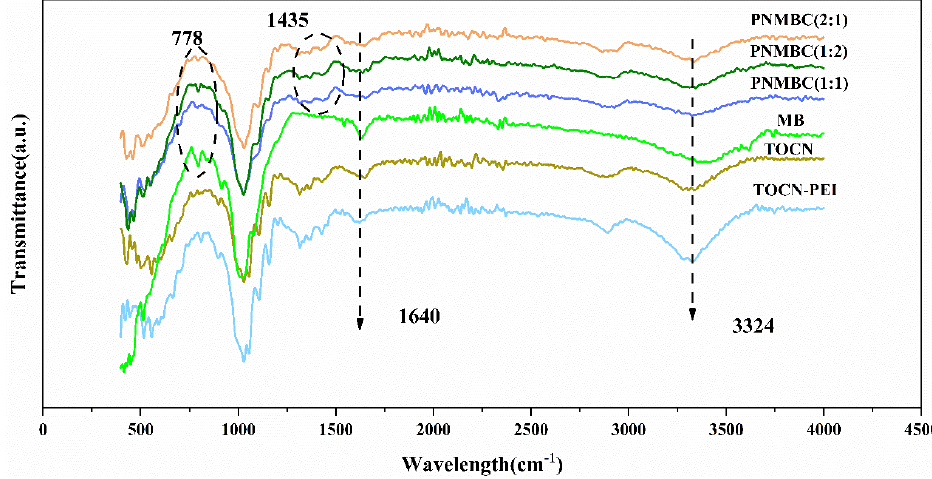
Figure 2. FT-IR spectra of the modified nanocellulose and PNMBC biosorbent: 2:1, 1:2, and 1:1 refer to the different mass ratios of PEI-modified TEMPO cellulose nanoparticles (TOCN–PEI) and magnetic bentonite (MB).